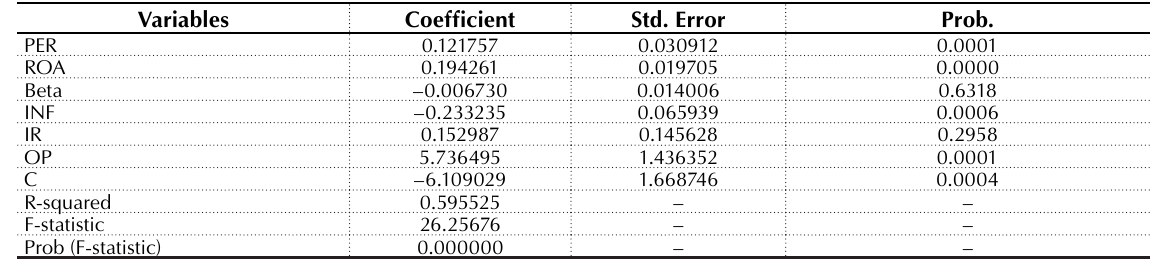
Table 3. Panel data regression results